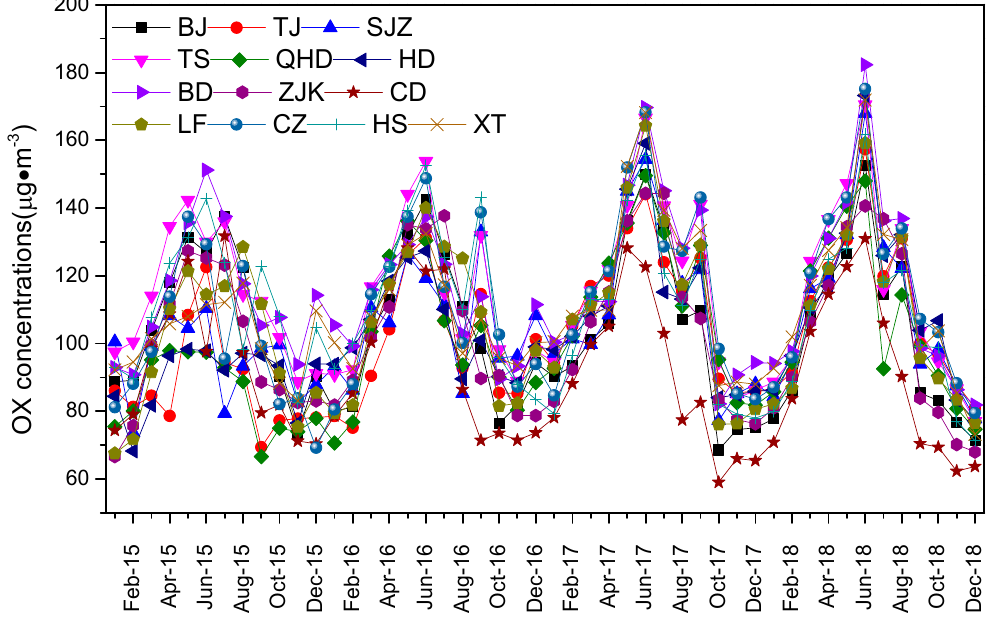
Figure 5. oxidant (OX) concentrations in BTH area. Figure 5. Oxidant (OX) concentrations in BTH